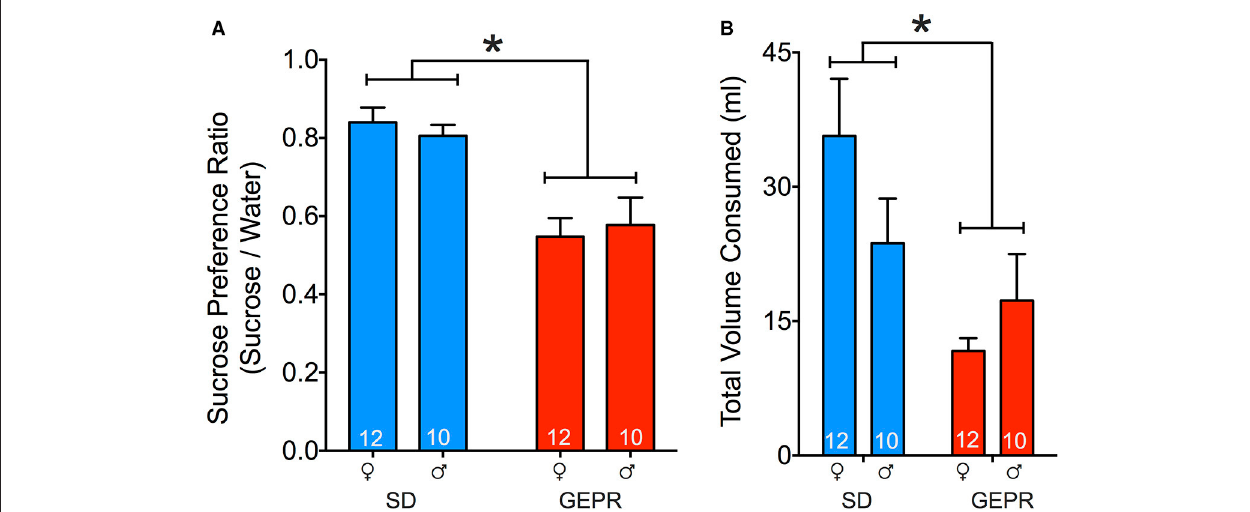
FIGURE 7 | Sucrose preference test. (A) GEPR-3s displayed a significantly lower sucrose preference ratio than SD rats [* F (1,40) = 29.3, P < 0.0001]. Pairwise comparisons showed that decreased sucrose preference in GEPR-3s was significant in both sexes female: P = 0.001, male: P = 0.003, Holm-Sidak corrected.